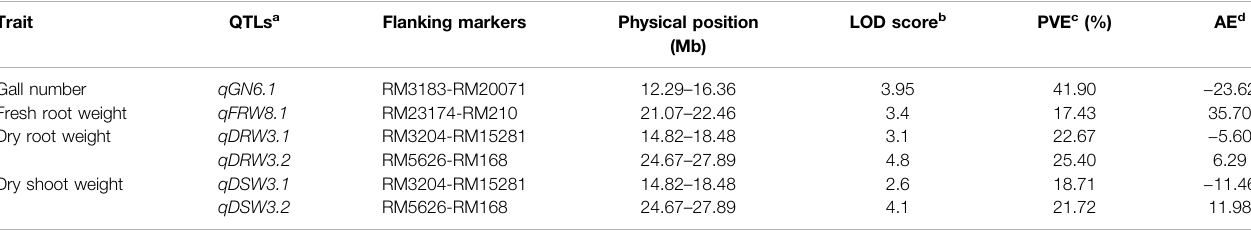
TABLE 3 | Chromosomal locations and parameters associated with the quantitative trait loci (QTL) for resistance to rice root-knot nematode in BC 1 F 1 population derived from the cross of PR121 (S) and O. glaberrima acc. IRGC102206 (R). Trait